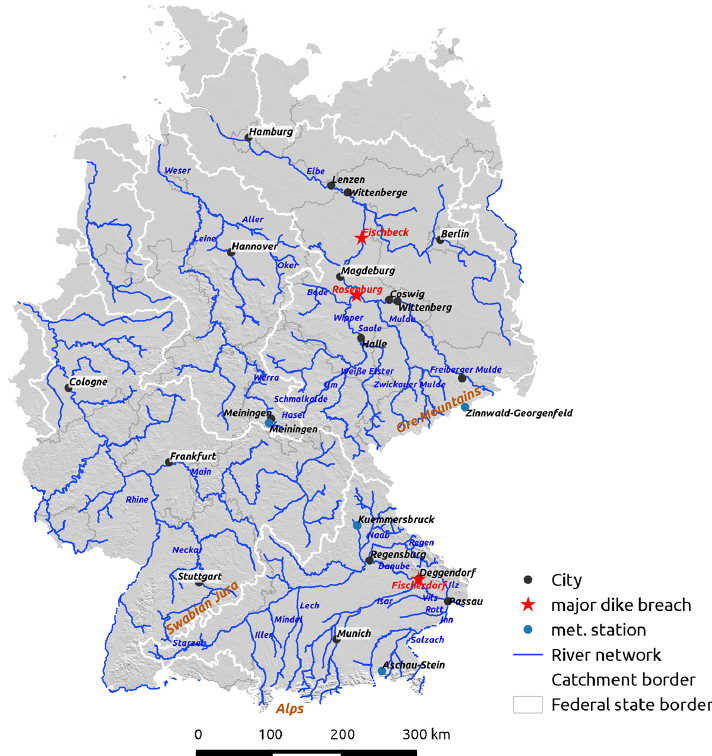
Figure A1. Outline map of geographic locations referred to in the text.